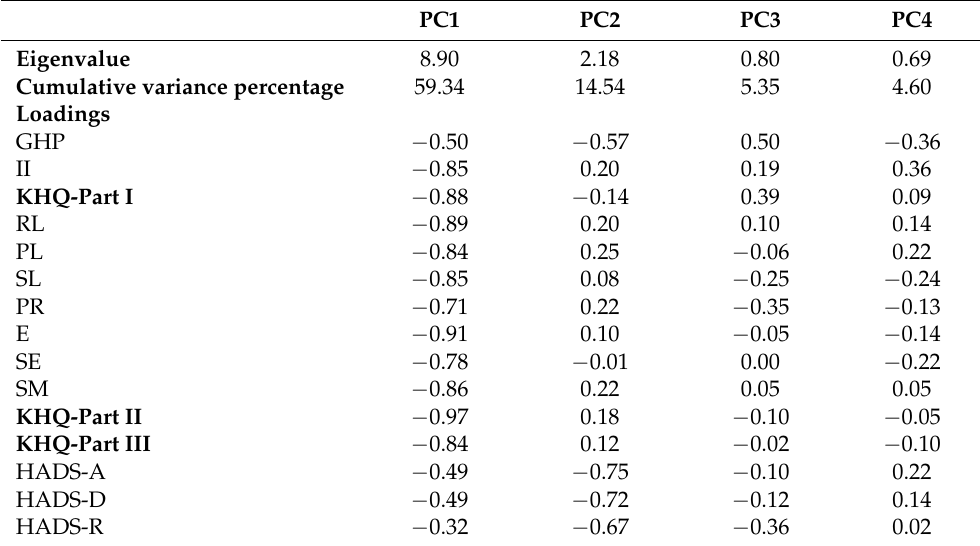
Table 8. Eigenvalues, the percentage of cumulative explained variance and loadings of the first four principal components of PCA of KHQ subscales and HADS